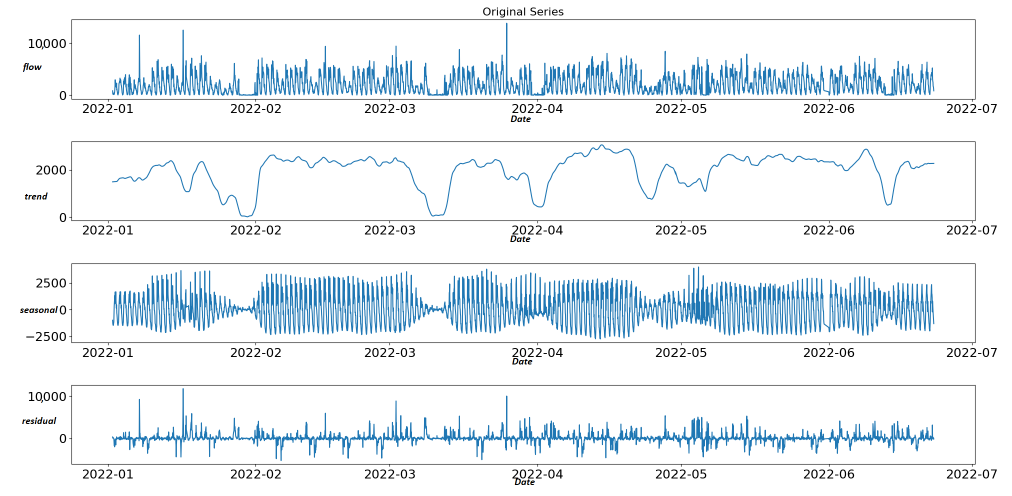
Figure 4. STL decomposition of time series of sensor MS734.